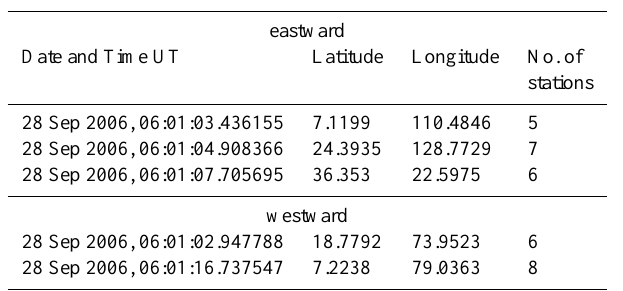
Figure 6. Spectrogram display of sferics received in 1s and the colour chart. Fig. 6. Spectrogram display of sferics received in 1s and the colour